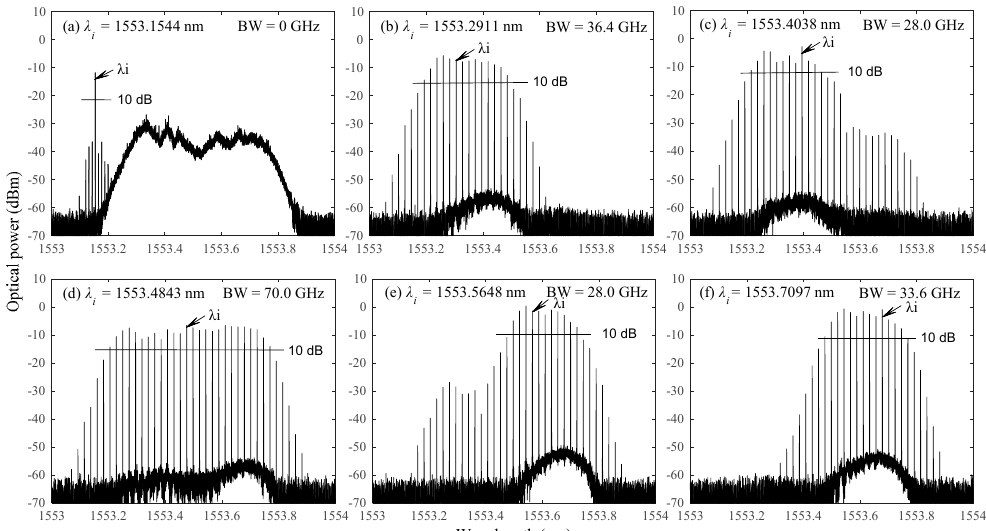
Figure 8. Experimentally measured total-OFC output from the gain-switching VCSEL under optical injection with fixed P i = 266.80 µ W and di ff erent values of λ i , where ( a ) λ i = 1553.1544 nm, ( b ) λ i = 1553.2911 nm, ( c ) 1553.4038 nm, ( d ) λ i = 1553.4843 nm, ( e ) λ i = 1553.5648 nm, and ( f ) λ i =1553.7097 nm.